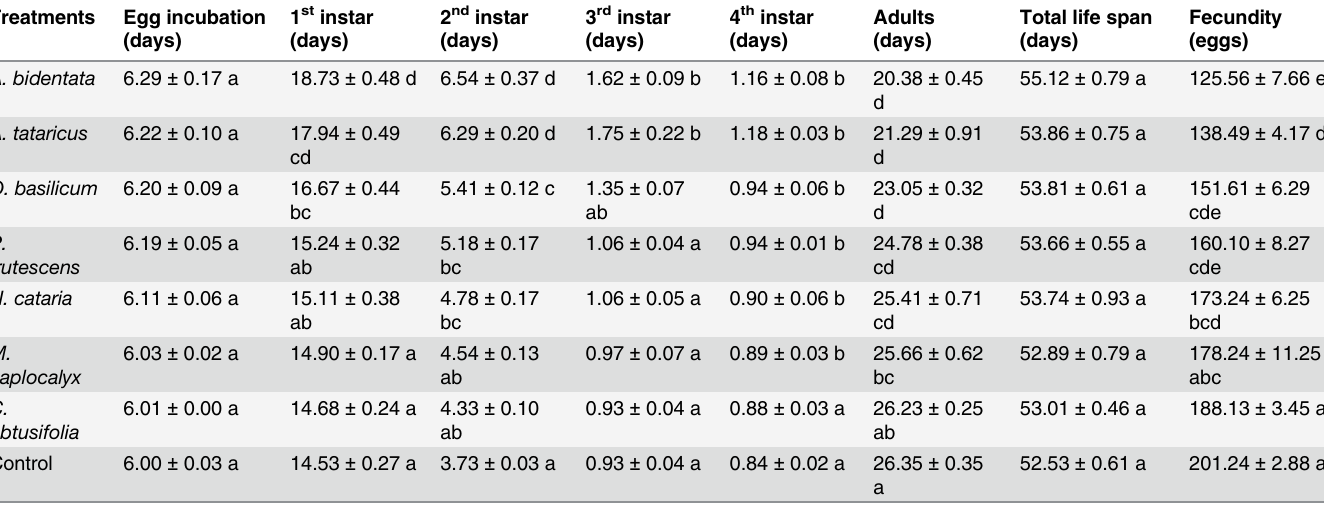
Table 2. Life history parameters (mean ± SE) of grape phylloxera treated by aqueous root extract of seven Chinese medicinal herbs.